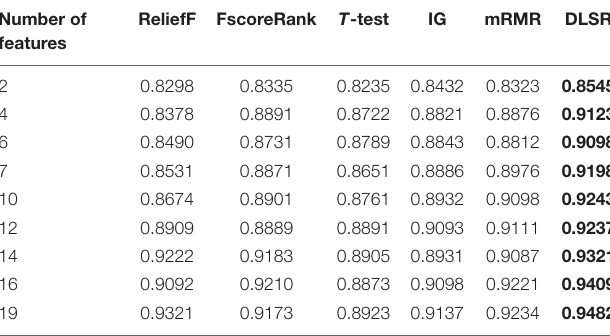
TABLE 2 | Psychological satisfaction classification performance of all models in terms of accuracy. Number of